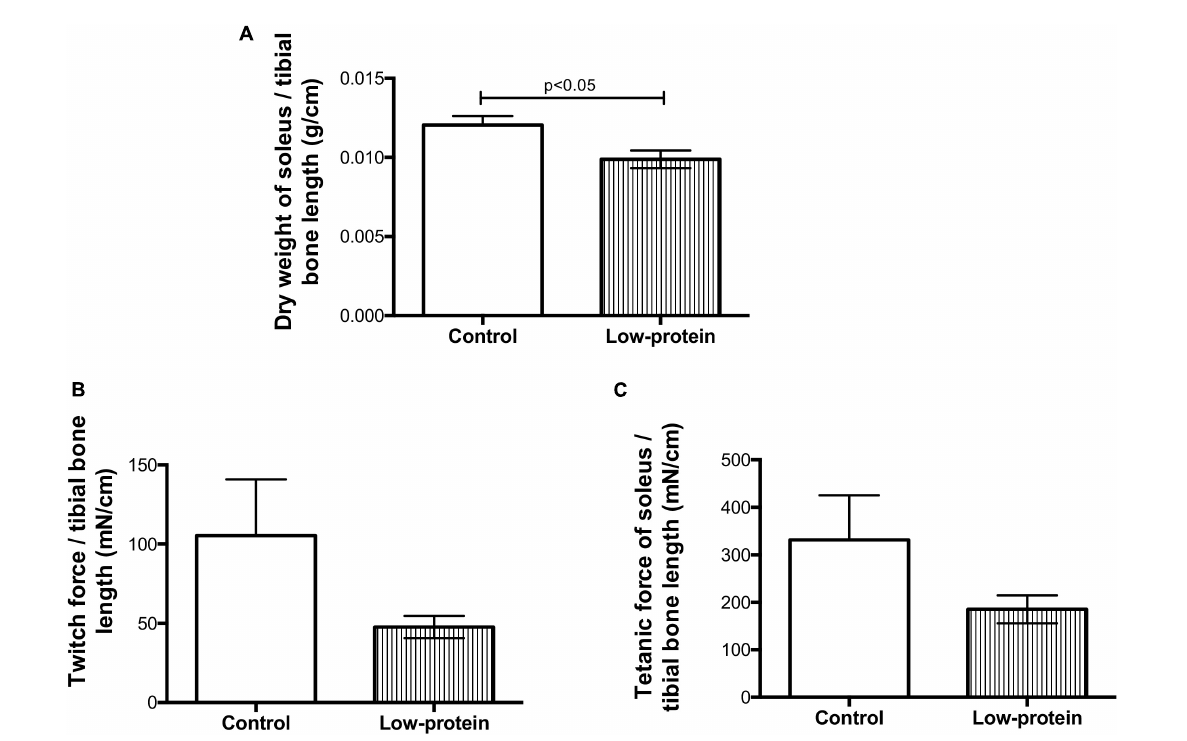
FIGURE2 Long-term effects of low-protein diet during early life on mass and function of soleus muscle in rats. (A) Dry weight, (B) twitch force, and (C) tetanic force in soleus muscle of 7-month-old pups born to mothers fed a normoproteic (control, n = 6–10) or low-protein (LP, n = 6–10) diet during pregnancy and lactation. Results were analyzed using unpaired t -test. Values expressed as mean ±